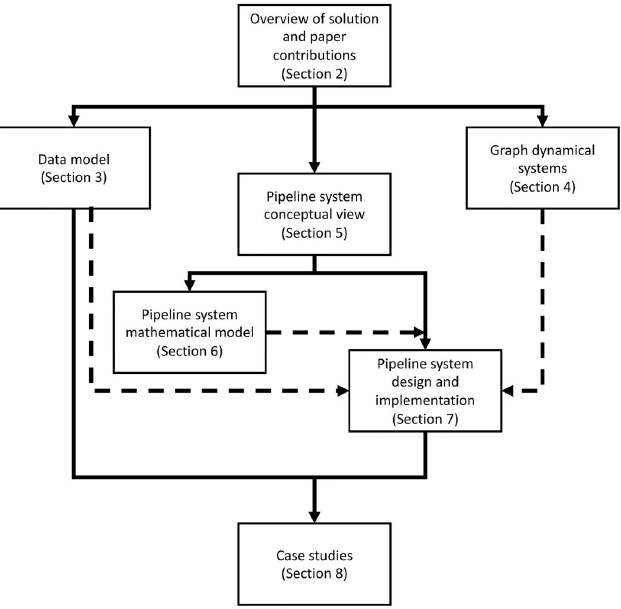
Fig 2. Roadmap of, and relationships among, sections in this manuscript. Arrows indicate dependencies among sections, and dashed arrows identify the theoretical models that impact the design and implement of the software pipeline system. The Introduction, Related Work, and Conclusions are not shown. See text for details.